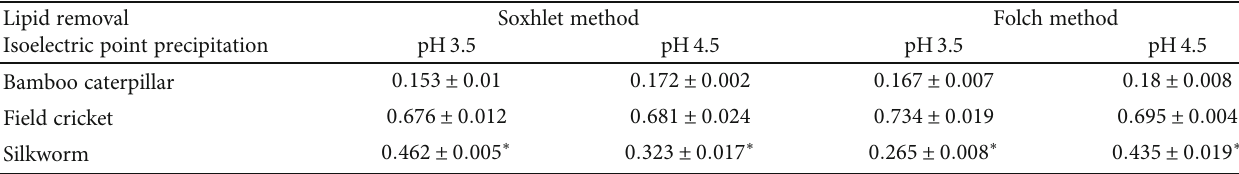
Table 3: Protein content (mg/mg defatted insect) of defatted insects after lipid removal at di ff erent pHs followed by isoelectric point precipitation.